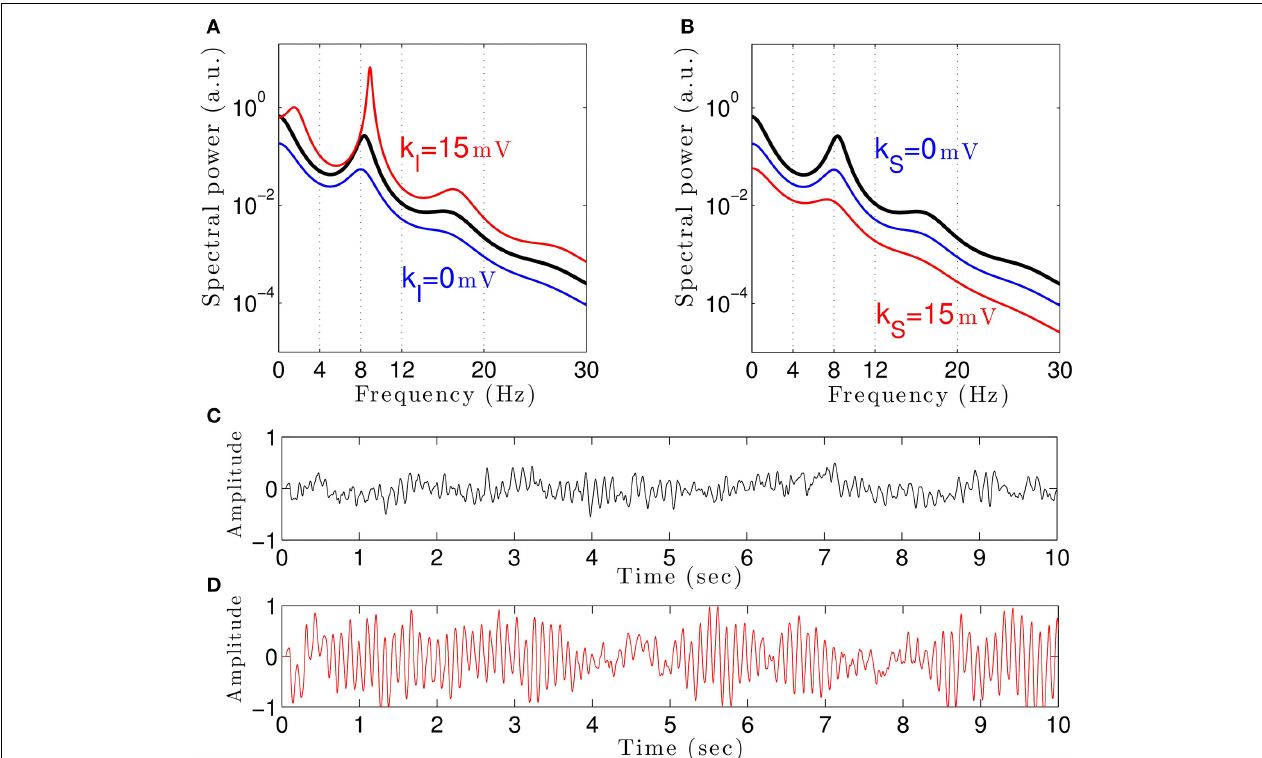
FIGURE 3 | The theoretical EEG power spectrum in the baseline and in the sedation condition with and without tonic inhibition in the cortical inhibitory neurons I in (A) and the thalamic relay neurons S in (B) and corresponding simulated EEG time-seris. In (A) the administration of propofol without tonic inhibition (blue line) attenuates the power spectrum compared to the baseline condition (black line) while the tonic inhibition (red line) increases the global power and generates oscillatory activity in the δ − frequency range. In (B) increasing the anesthetic concentration yields a global power decrease in the sedation condition without tonic inhibition (blue line) and a further power decrease in the presence of tonic inhibition (red